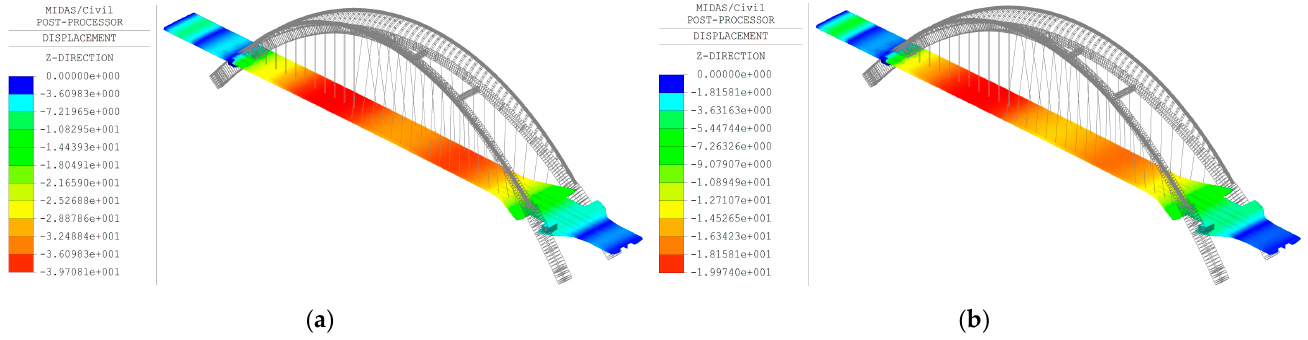
Figure 12. The vertical displacement of the main girder (unit: mm): ( a ) vehicle load; ( b ) crowd load.